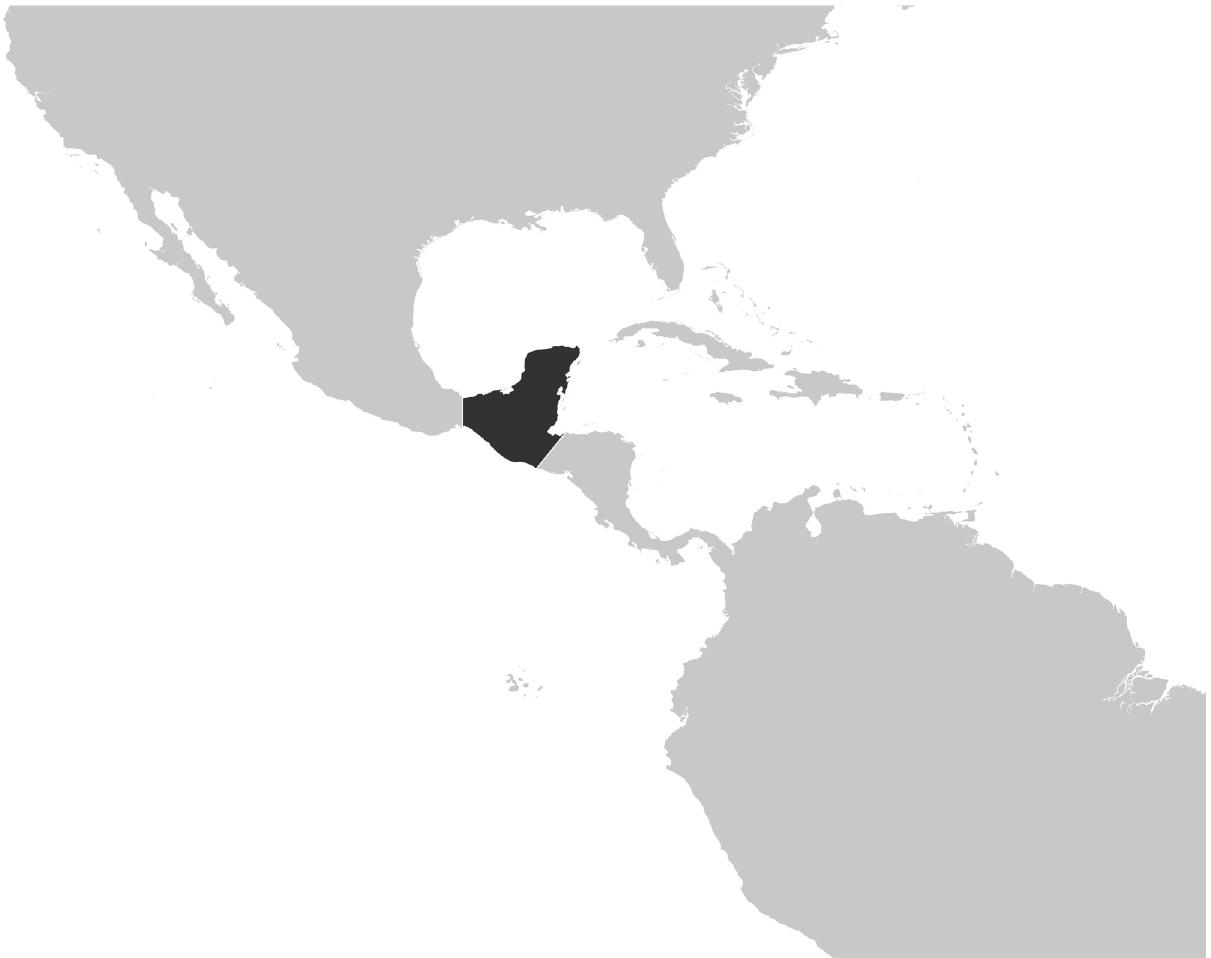
Fig 1. Map showing the geographic location of the Classic Maya. The dark grey area roughly corresponds to the Classic Maya region.